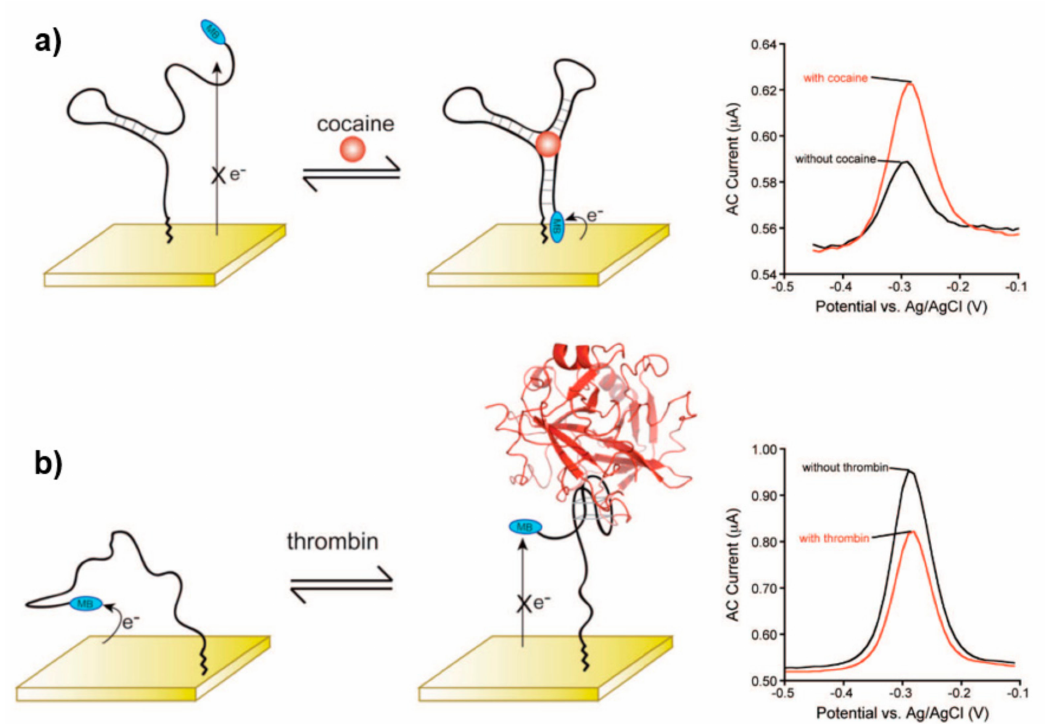
Figure 1. Schematic representation of ( a ) the “signal-on” strategy involving a methylene blue (MB)-tagged cocaine aptamer immobilized on a gold surface: the addition of the target induces the folding of the aptamer, bringing the redox tag near the electrode and increasing response current; ( b ) the “signal-off” strategy involving a MB-tagged thrombin aptamer immobilized on a gold surface: upon target binding, the aptamer undergoes a conformational change resulting in a decrease of the redox current. Reprinted with permission from [94]. Copyright 2008 American Chemical